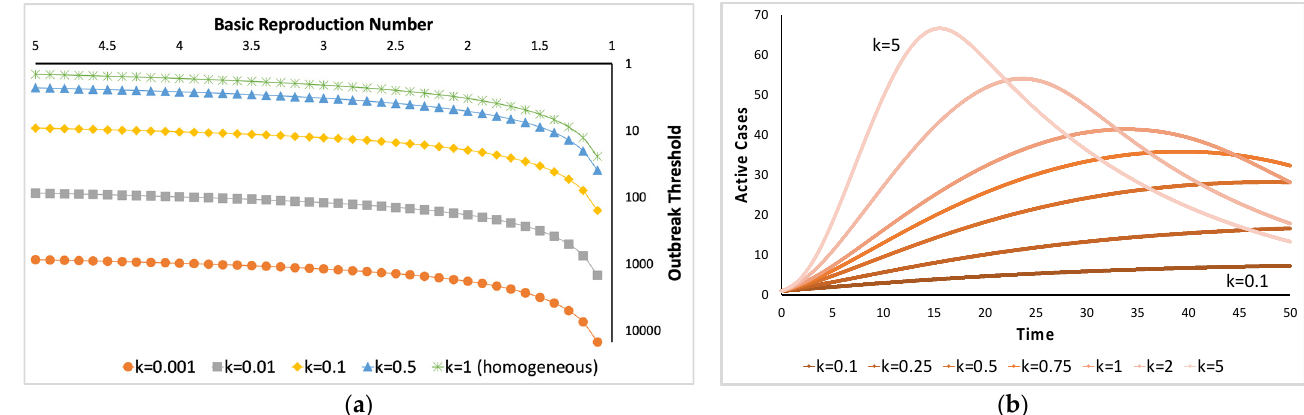
Figure 4. Effect of heterogeneity and overdispersion in epidemics. In both figures, 𝑘 near zero represents more heterogeneity and high overdispersion. ( a ) 90% probability, 𝑘 = 1 is assumed to be equivalent to a homogeneous transmission; ( b ) 𝑘 → ∞ represents random transmission (e.g., Poisson-distributed spread of infectious disease).